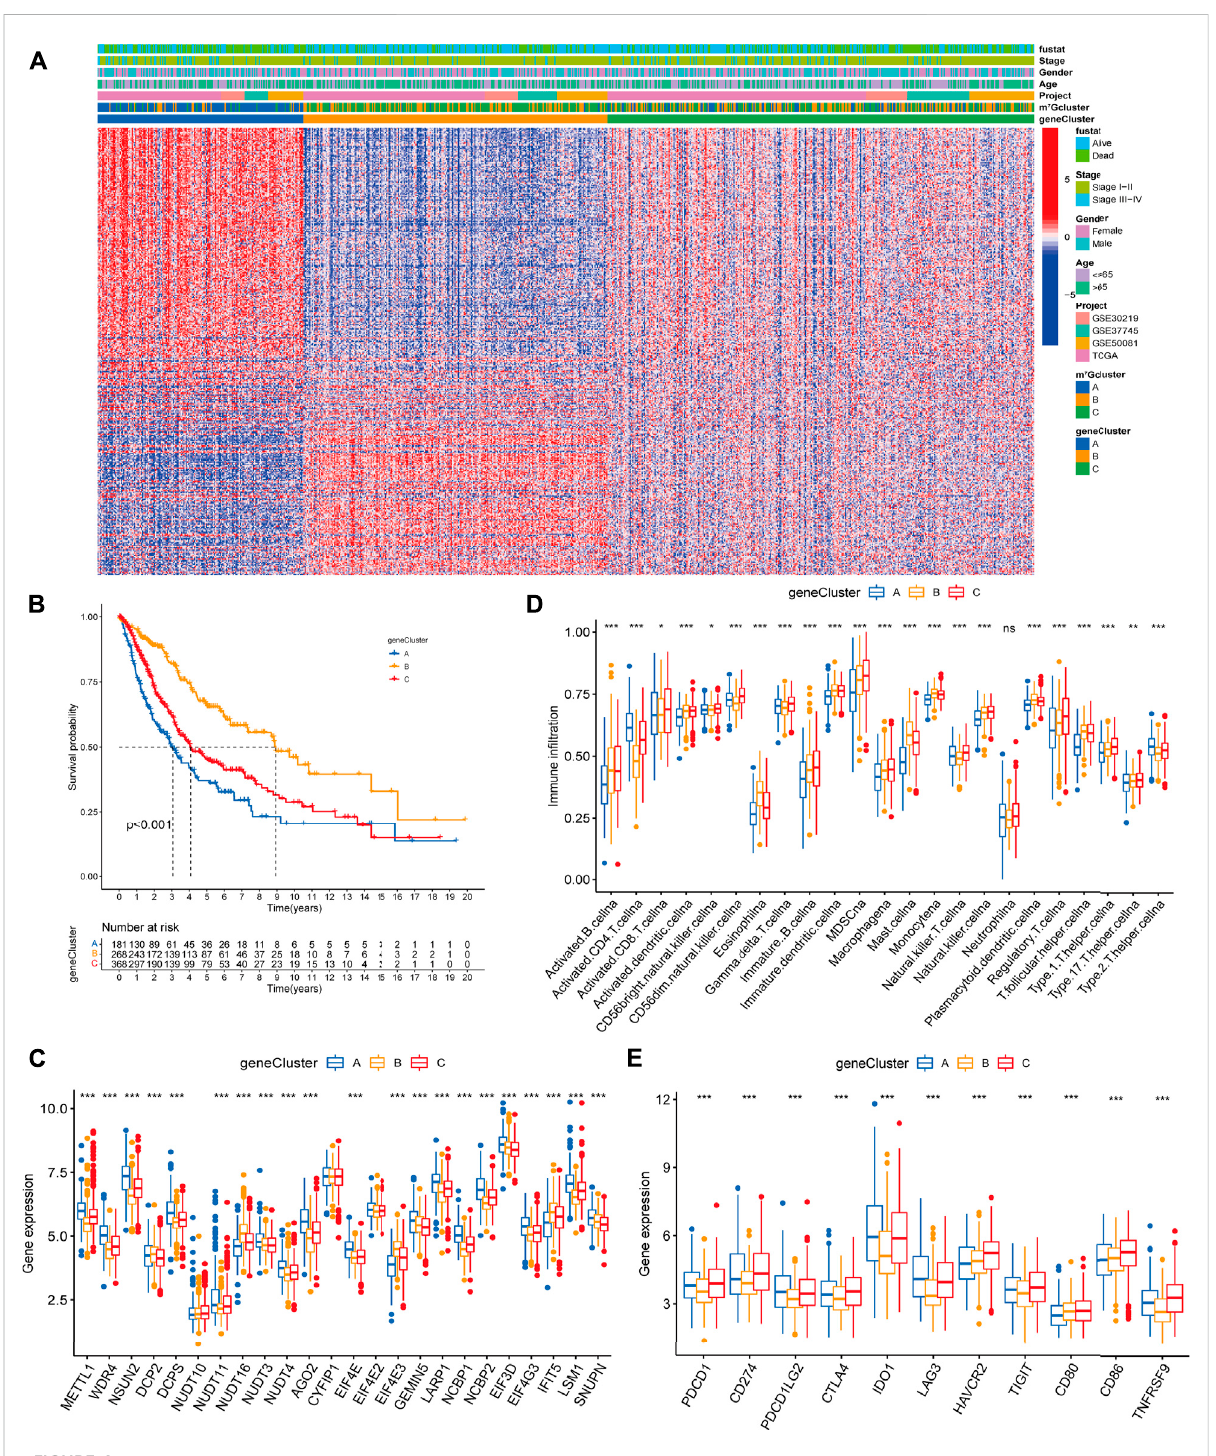
FIGURE 4 Clinicopathologic characteristics, genomic pro fi ling and tumor microenvironment characteristics among distinct m 7 G modi fi cation-related genomic subtypes. (A) The heatmap visualizes the gene expression levels across the whole genome and comparison of baseline clinicopathological characteristics in each sample. Blue represents low expression and red represent high expression. (B) Survival analyses for the three gene clusters based on 817 patients with LUAD from four cohorts (TCGA-LUAD, GSE30219, GSE50081, GSE37745). (C) Difference in the m 7 G regulators expression among three gene clusters. (D) Difference in the abundance of 23 TME in fi ltrating cells among three m 7 G gene clusters. (E) Difference in the immune-checkpoint related gene expression among three gene clusters. The horizontal line indicates the median, the lower and upper boundariesoftheboxestheinterquartilerange,andthedotstheoutliers.Asterisksindicatestatisticalsigni fi cance,* p < 0.05,** p < 0.01,*** p <